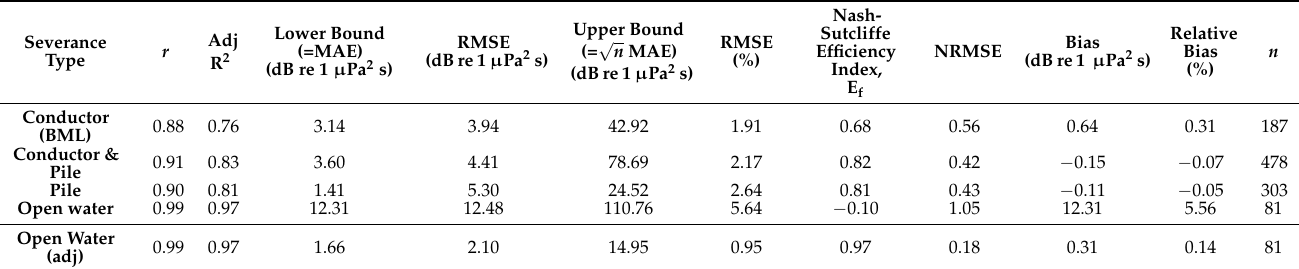
Table 6. Statistical evaluation of EDGAR simulated values and measured Gulf of Mexico project data for combined conductor, pile and conductor/pile severance BML and for open water blasts (before and after model adjustment applied). Adj R 2 : adjusted coefficient of determination; MAE: mean absolute error; RMSE: root mean squared error; and NRMSE: normalised root mean squared